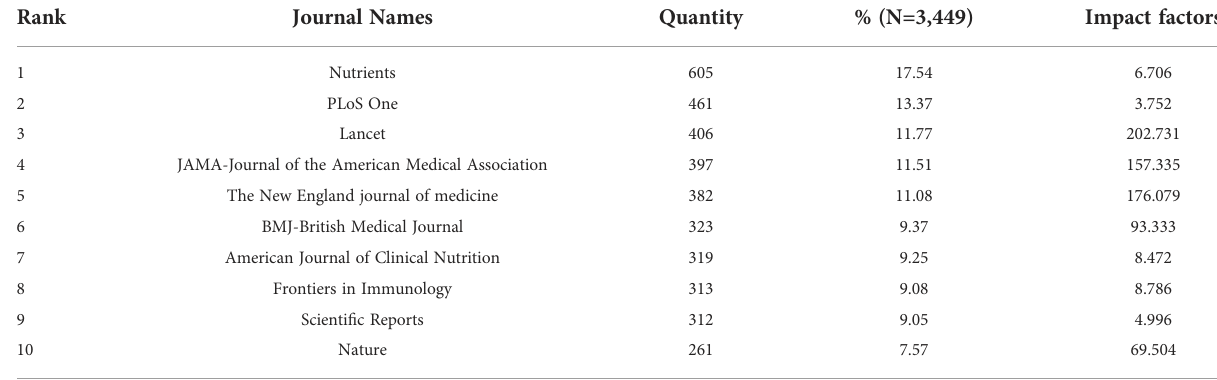
TABLE 2 Top 10 frequency cited